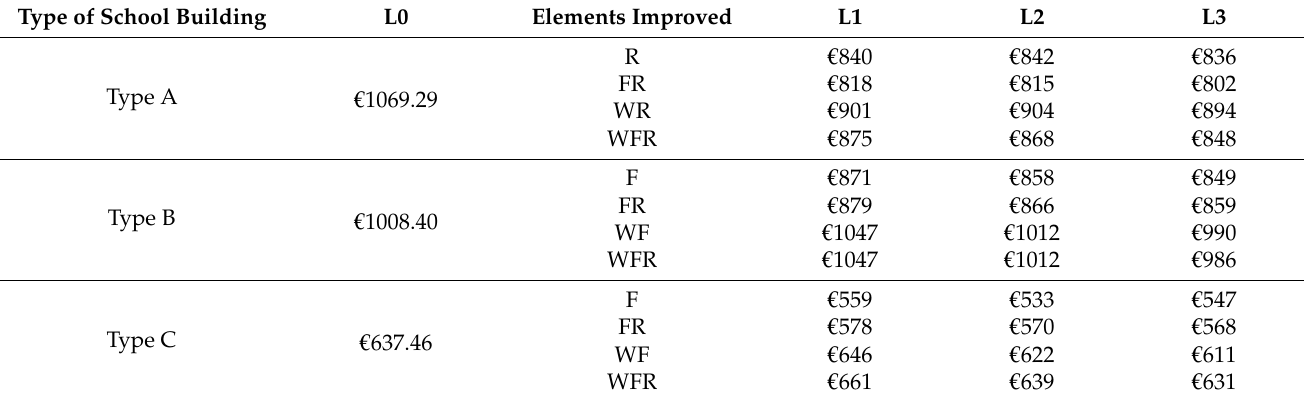
Table 5. 30-year global cost of initial state L0 per m 2 , according to type of school building, and global cost of sets of measures per m 2 , including those with better energy